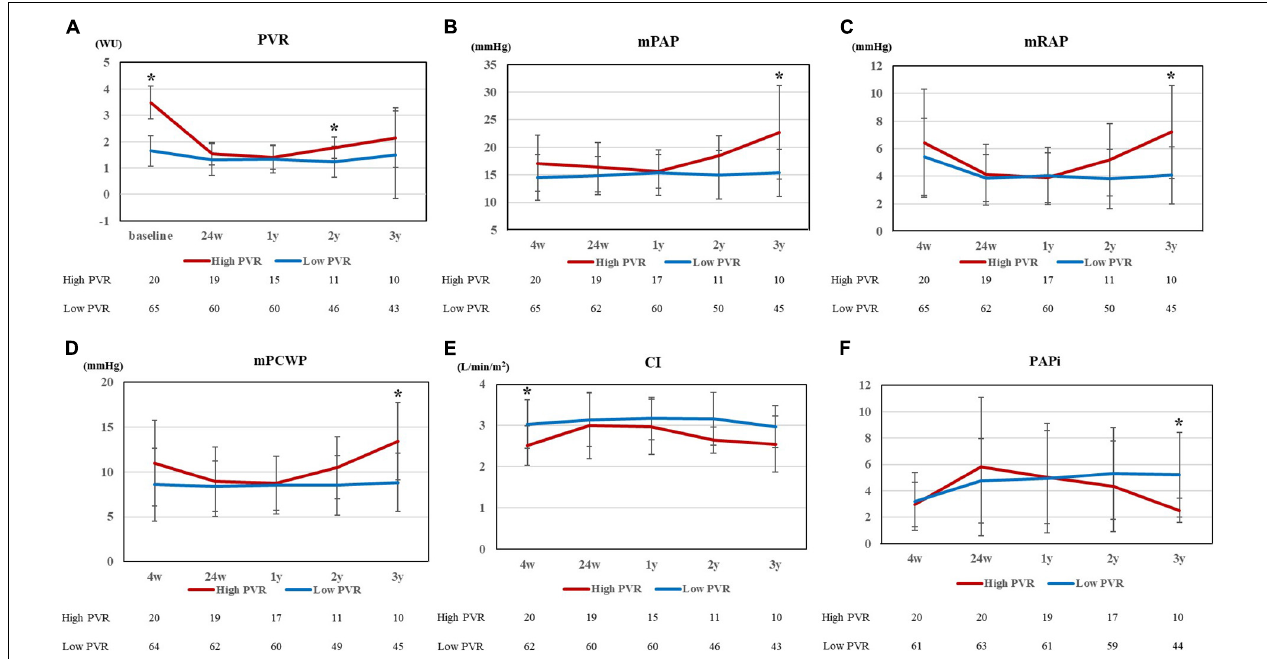
FIGURE 2 | (A) PVR at 5 points (baseline, 24 weeks, 1 year, 2 years, and 3 years after HTx), (B) mPAP, (C) mRAP, (D) mPCWP, (E) CI, and (F) PAPi at 5 points (4 weeks, 24 weeks, 1 year, 2 years, and 3 years after HTx) for high and low PVR group. PVR, pulmonary vascular resistance; HTx, heart transplantation; mPAP, mean pulmonary artery pressure; mRAP, mean right arterial pressure; mPCWP, mean pulmonary capillary wedge pressure; CI, cardiac index; and PAPi, pulmonary artery pulsatility index. * p < 0.01.